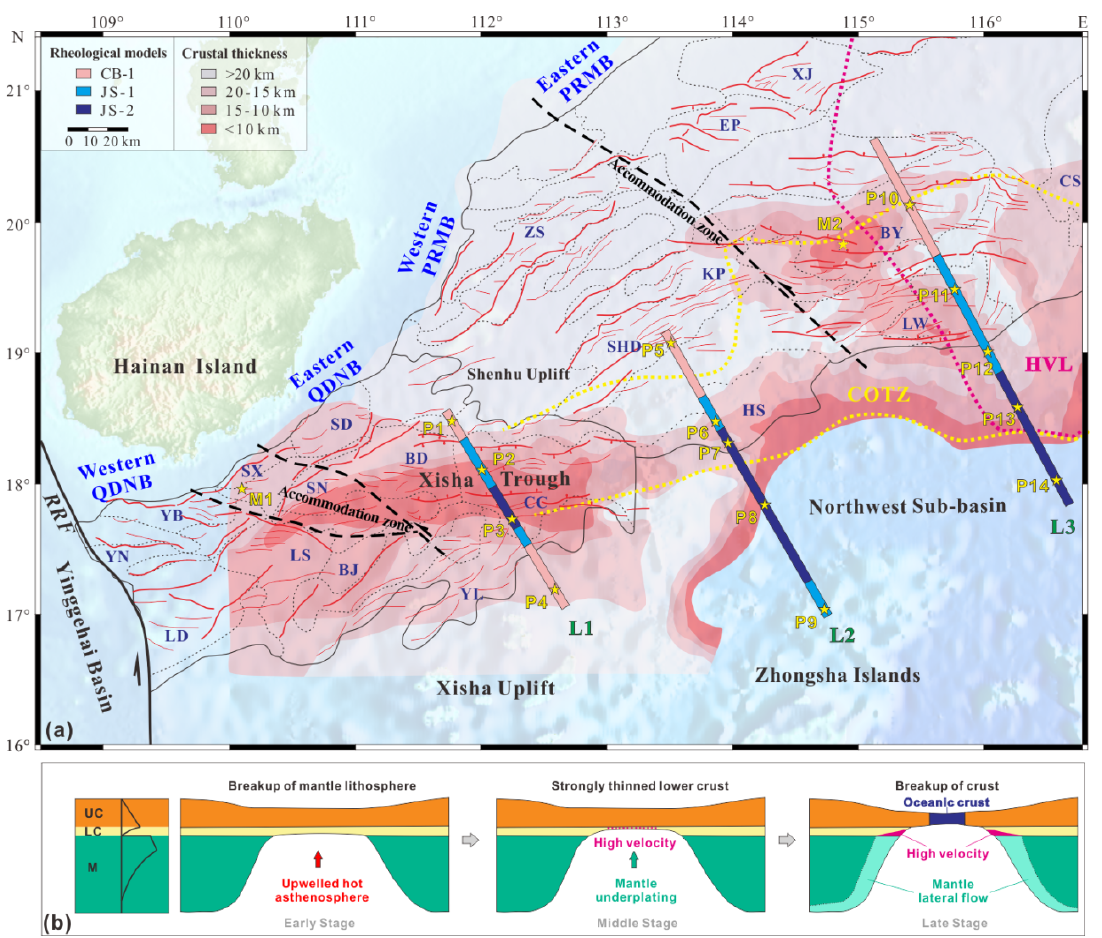
Figure 10. ( a ) Estimated distribution of crustal thickness [89] and rheological models. The classical rheological models of CB ‐ 1, JS ‐ 1, and JS ‐ 2 were recognized by the pink, light blue, and dark blue rectangles, respectively. The locations of M1 and M2 are the typical locations for comparative research in the paper. ( b ) The non ‐ uniform extension model modified from Huismans and Beaumont [31].